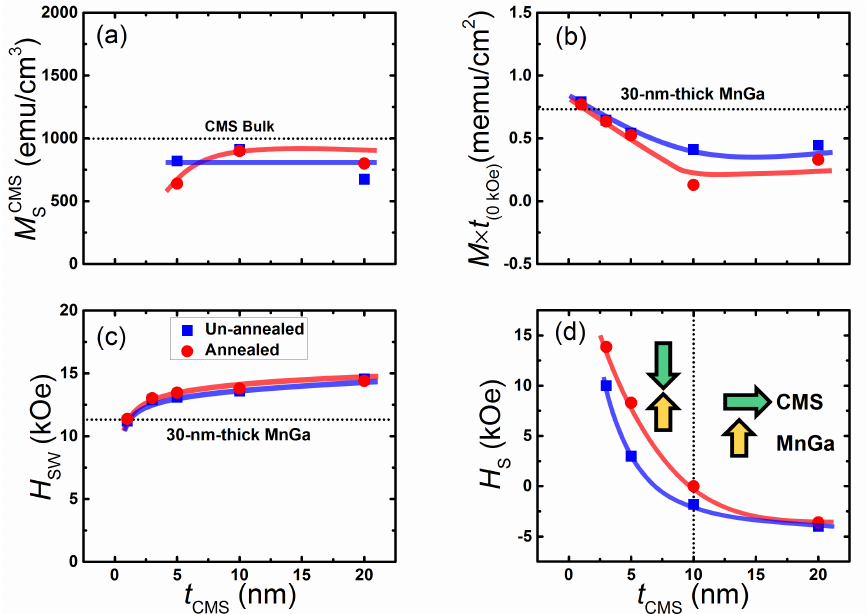
Figure 5. ( a ) Thickness dependence of saturation magnetization for the CMS film ( M CMS ( b ) Thickness dependence of remnant magnetization ( M × t ( d ) saturation fields in antiparallel state ( H